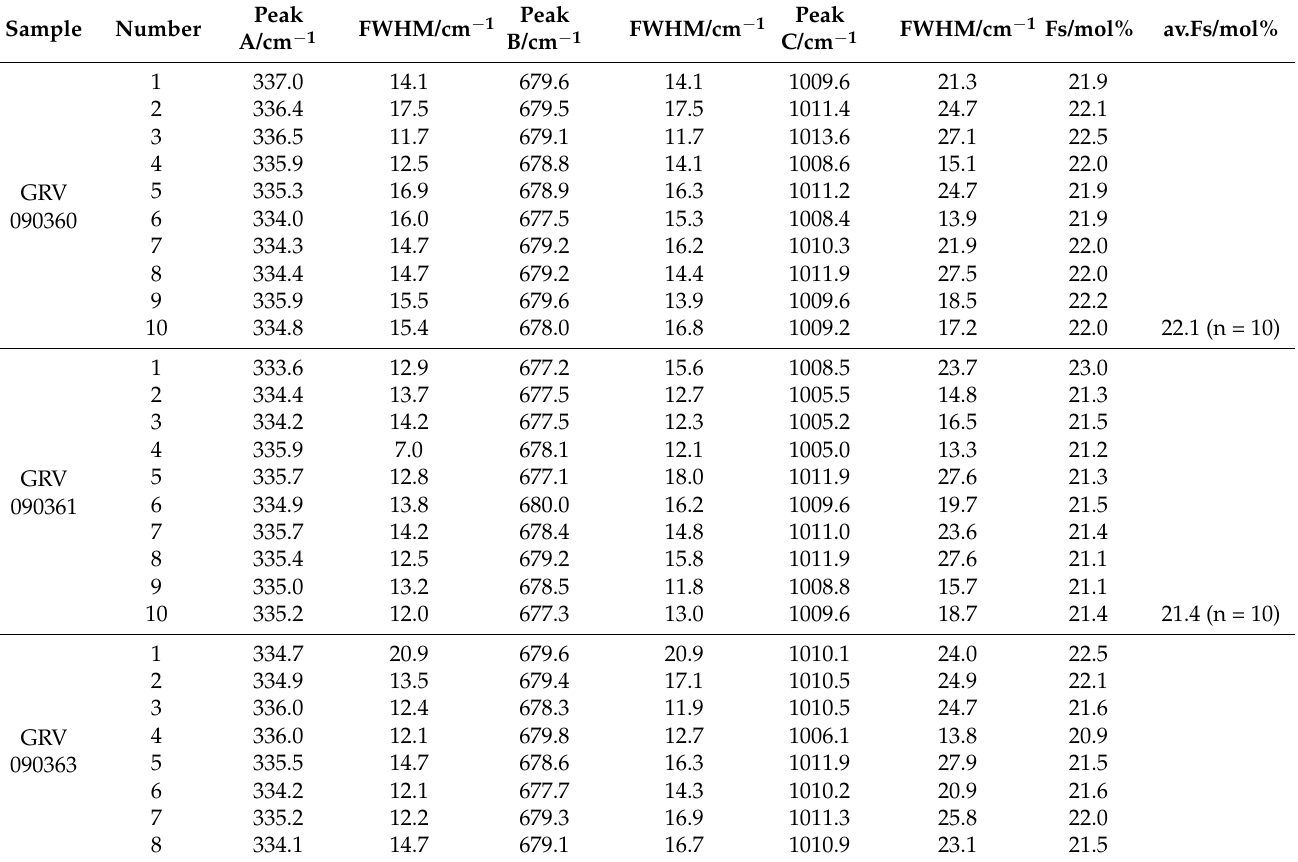
Table A2. The Raman spectrum and corresponding EPMA data of pyroxene in selected